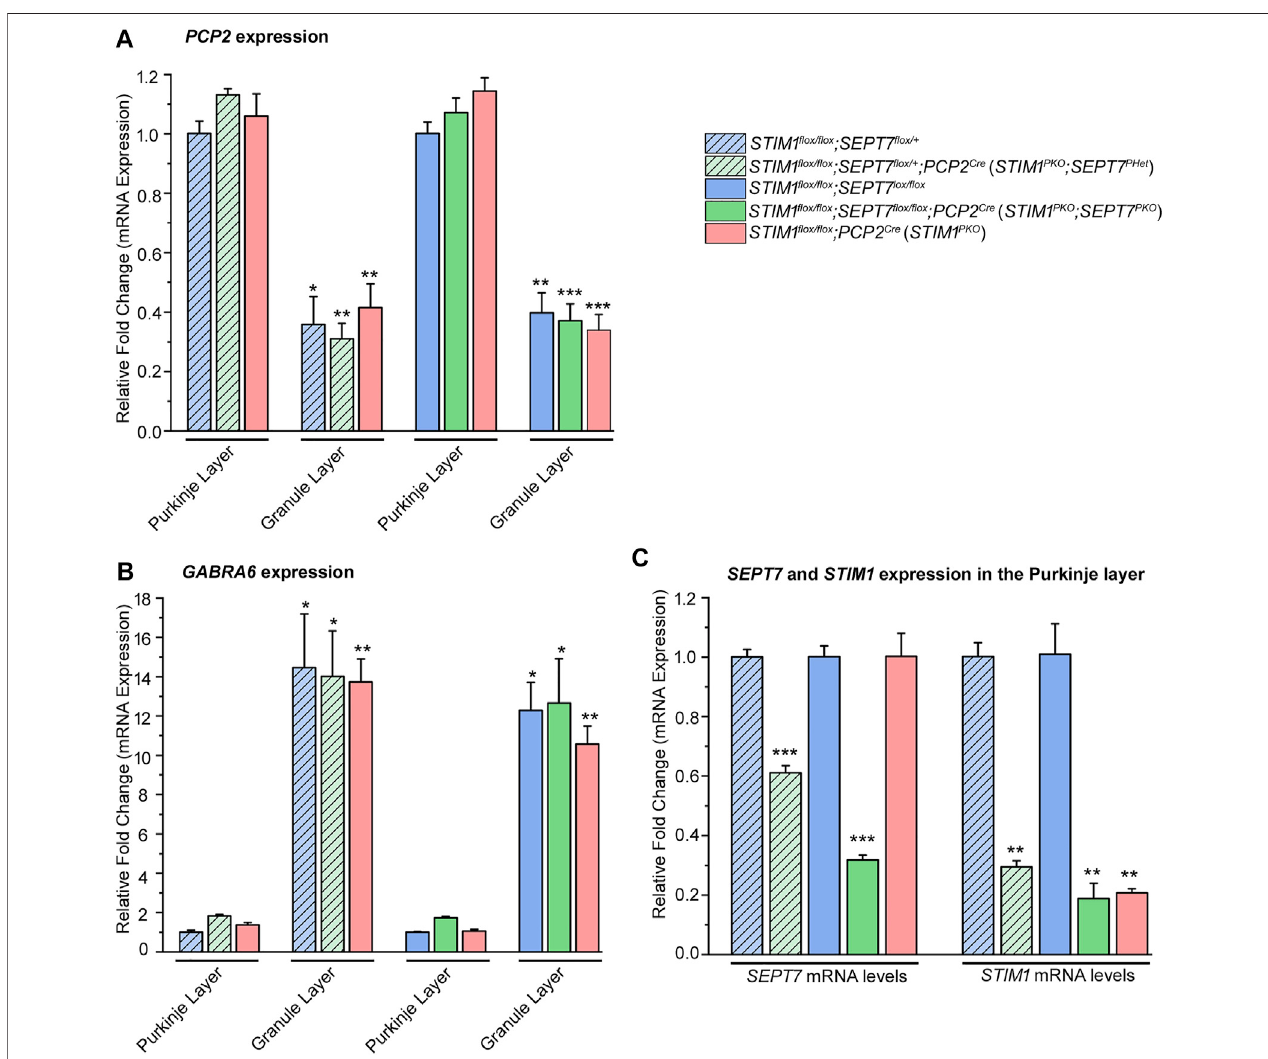
FIGURE 2 | Characterization of SEPT7 and STIM1 expression levels. (A) Bar graphs indicating relative expression of Purkinje neuron marker, PCP2 (Purkinje cell protein 2) normalized to GAPDH (glyceraldehyde 3-phosphate dehydrogenase) in samples of the Purkinje neuronal layer (PNL) and the granule layer (GL). PCP2 expression levels of GL are relative to PNL for each genotype, and statistical signi fi cance is indicated above the bar graph. (B) Bar graphs with relative expression of granule layer marker, GABRA6 (gamma-aminobutyric acid type A receptor subunit alpha 6) normalized to GAPDH levels in samples of the Purkinje neuronal layer and the granule layer. GABRA6 expression levels of GL are compared relative to those of PNL for each genotype, and statistical signi fi cance is indicated above the bar graph. (C) Bar graphs indicating fold changes in expression of SEPT7 and STIM1 normalized to GAPDH from microdissected Purkinje neuronal layer of each genotype. Fold changes are relative to that of its respective controls, and statistical signi fi cance is indicated above the bar graph. Data are presented as mean ± SEM, * p < 0.05, ** p < 0.01, *** p < 0.001; one-way ANOVA with post hoc Tukey ’ s test ( n (cid:1) 3 mice for all groups and n (cid:1) 4 for STIM1 PKO ; SEPT7 PHet , age — 1-year-old mice).